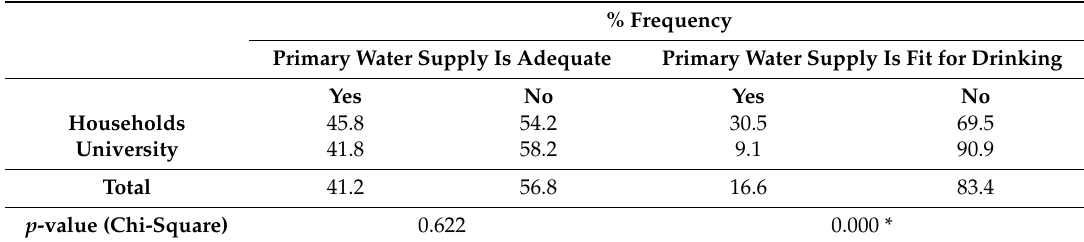
Table 5. Community’s perception of water supply by group